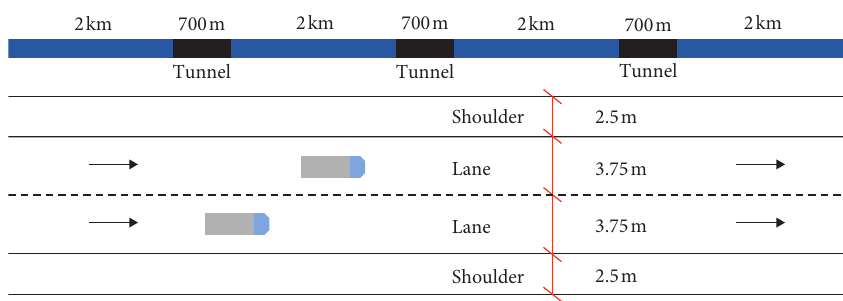
Figure 2: Experimental road